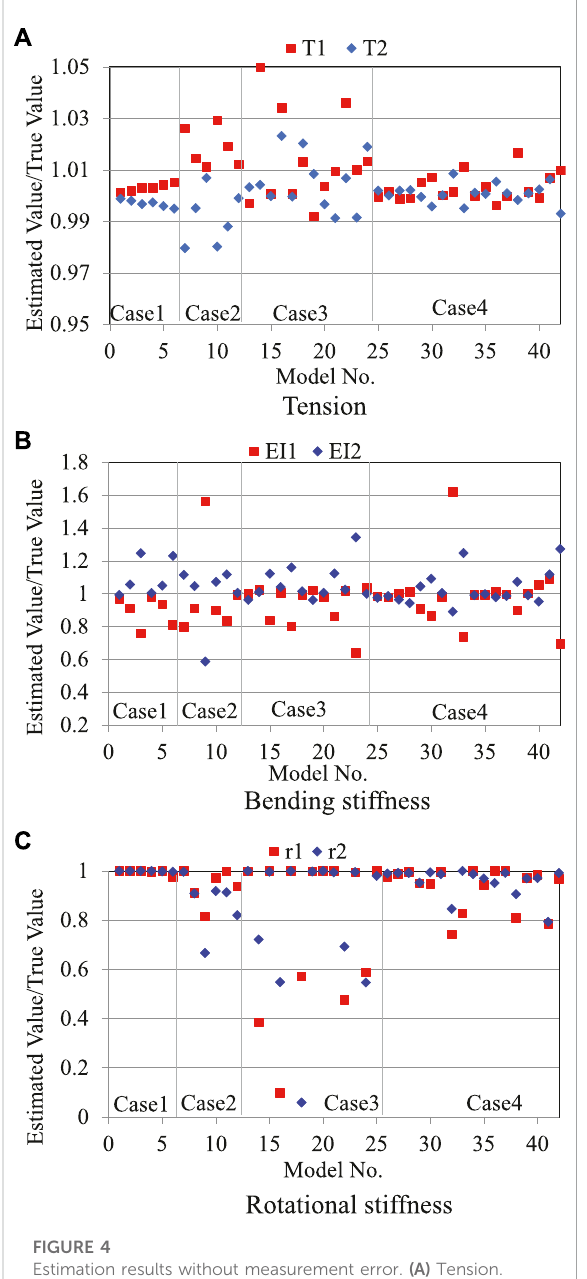
FIGURE 4 Estimation results without measurement error. (A) Tension. (B) Bending stiffness. (C) Rotational